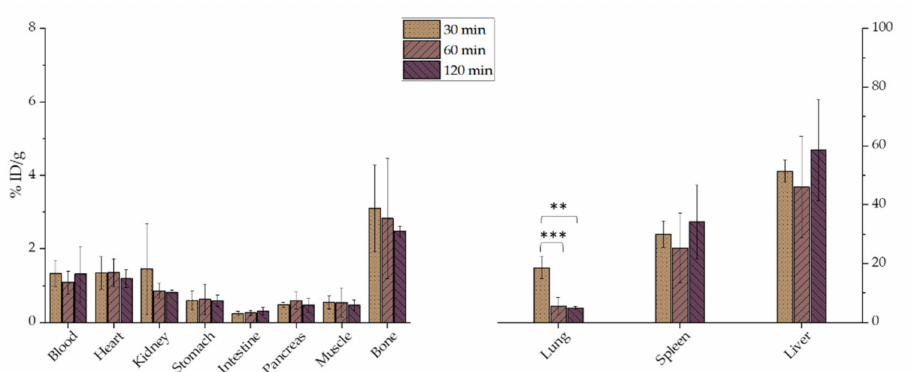
Figure 10. Biodistribution of [ 68 Ga]Ga-MagP MIONs in normal mice ( n = 3–5 mice per time point). Asterisks indicate the statistical significance of the difference between the results (* p < 0.05, ** p < 0.01, *** p < 0.001). Absence of asterisks denotes a nonsignificant statistical